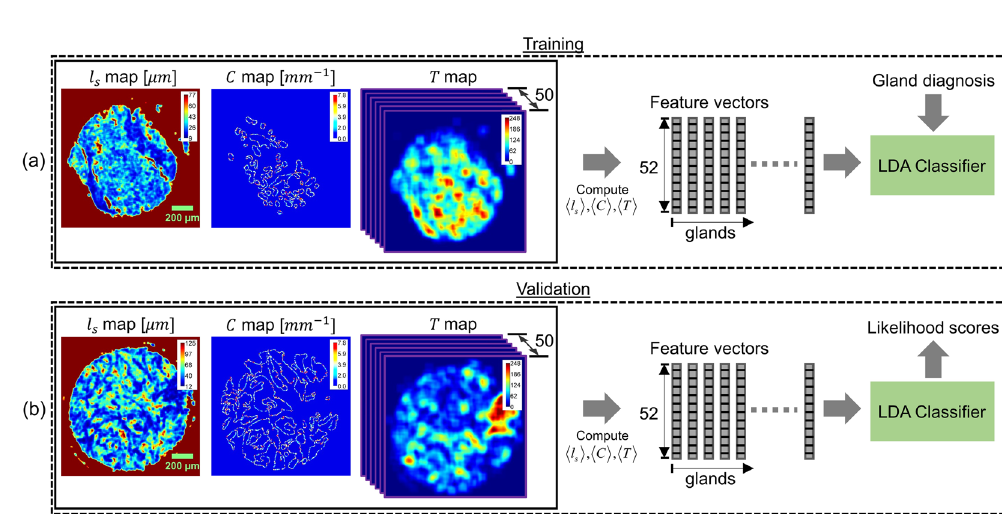
Figure 4. ( a ) Training and ( b ) Validation procedure for classifying glands as benign or